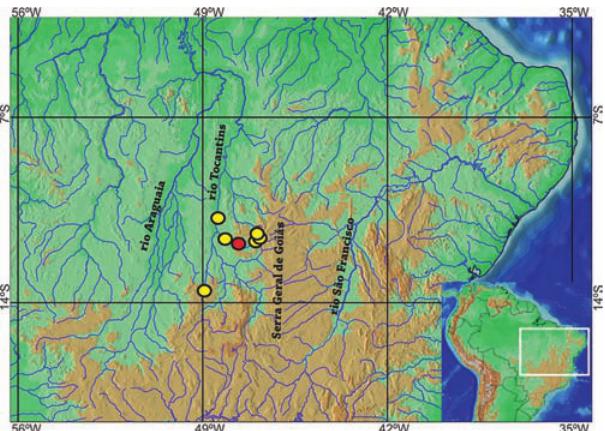
Fig. 4. Distribution of Hemigrammus ataktos in the middle rio Tocantins basin, central Brazil. Type locality represented by red